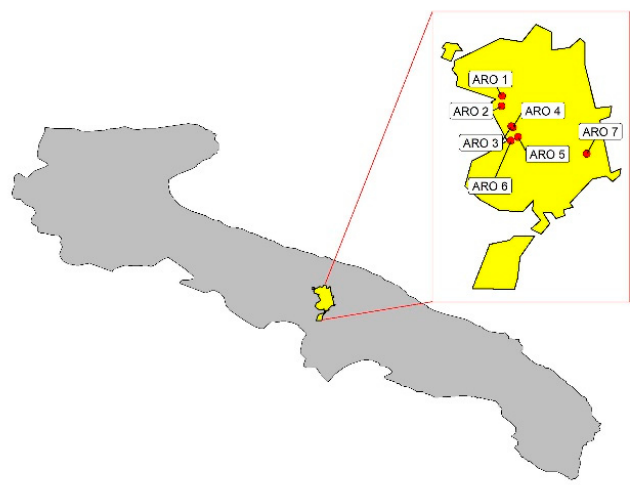
Figure 5. Localization of the different ARO populations genotyped in this study within the munici- pality borders of Acquaviva delle Fonti (Apulia Region, Southern Italy).